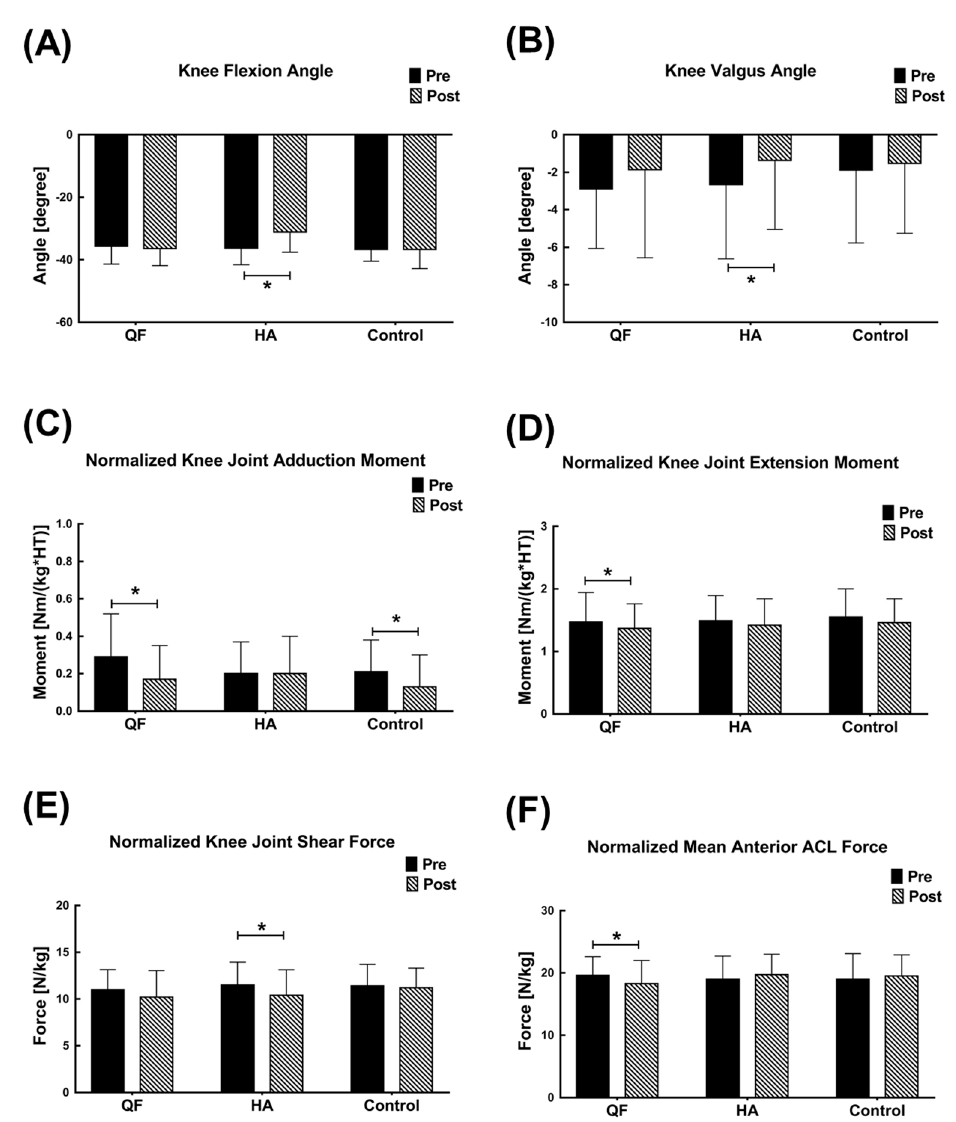
Figure 3. The mean and standard deviation of calculated variables. ( A ) Knee flexion angle; ( B ) knee valgus angle; ( C ) BM normalized knee joint adduction moment; ( D ) BM normalized knee joint extension moment; ( E ) BM normalized knee joint shear force; ( F ) normalized mean anterior ACL force. Pre-DDM condition in black, post-DDM in gray-dhaded. Significant differences between treatment conditions are denoted by asterisks (for detail, see Supplementary Table